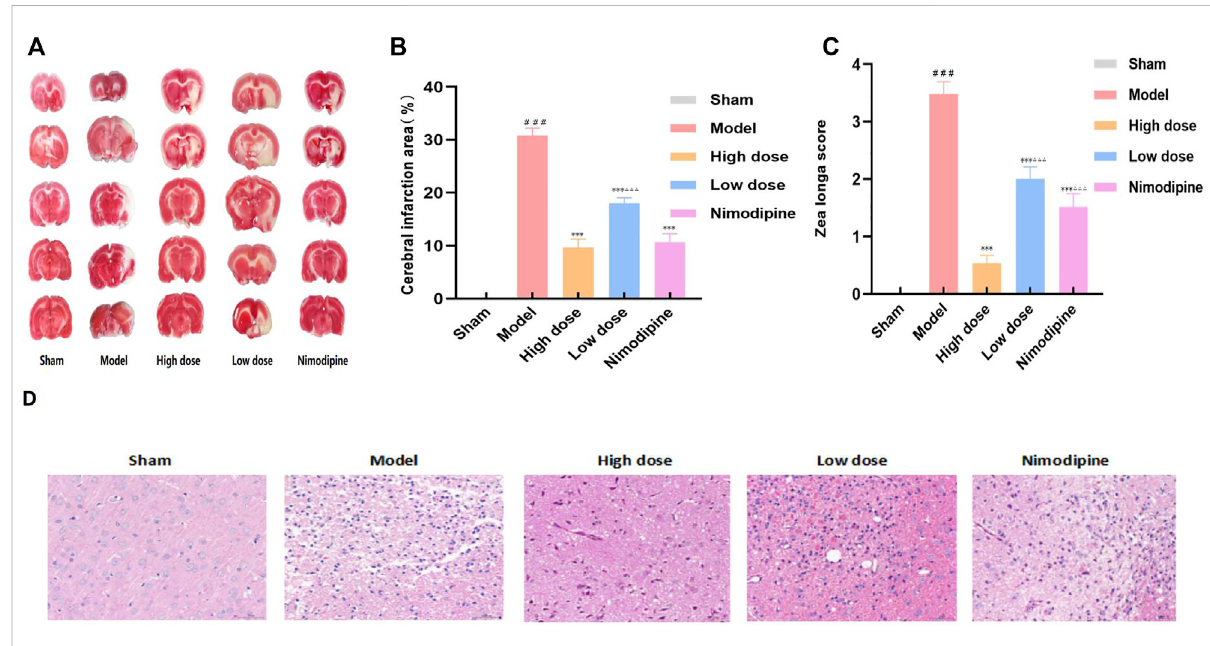
FIGURE 1 ZHTC improves motor nerve function, reduces cerebral infarction area and brain tissue damage in MCAO